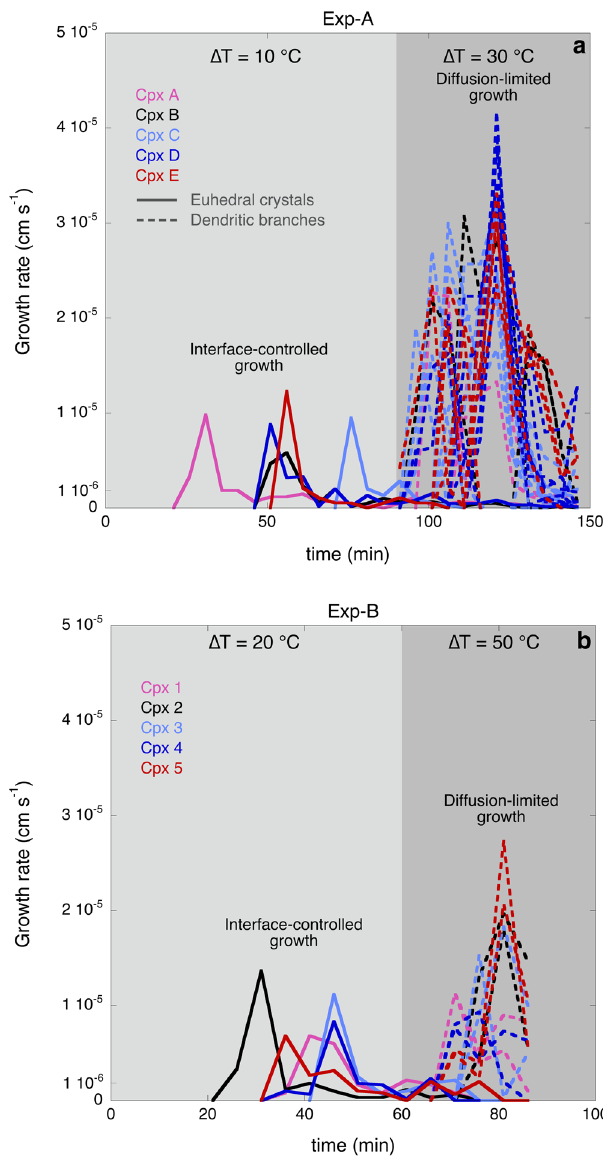
Fig. 4 Growth rate of clinopyroxene crystals as a function of the experimental time. a Plot showing the evolution of growth rates of 5 clinopyroxene crystals through time during the experiment Exp-A at Δ T = 10 °C (euhedral crystal shapes are promoted by interface-controlled growth) and at Δ T = 30 °C (dendritic crystal shapes are promoted by diffusion-limited growth). Light grey shading represents Δ T = 10 °C, dark grey shading represents Δ T = 30 °C. b Plot showing the evolution of growth rates of 5 clinopyroxene crystals through time during the experiment Exp-B at Δ T = 20 °C (euhedral crystal shapes are promoted by interface-controlled growth) and at Δ T = 50 °C (dendritic crystal shapes are promoted by diffusion-limited growth). Light grey shading represents Δ T = 20 °C, dark grey shading represents Δ T = 50 °C. The undercoolings ( Δ T ) investigated are calculated with respect to the clinopyroxene